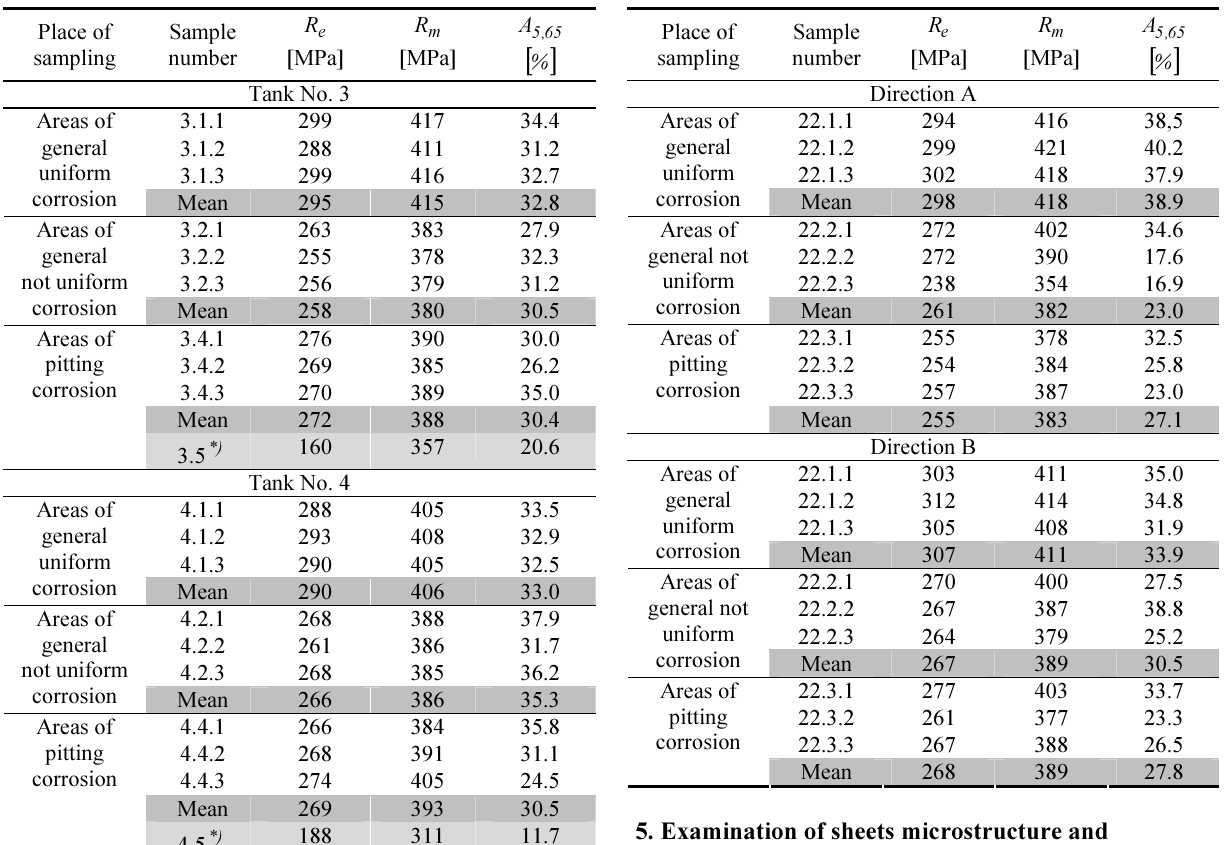
Table 1. Results of static tensile strength test of material from tanks No. 3 and 4